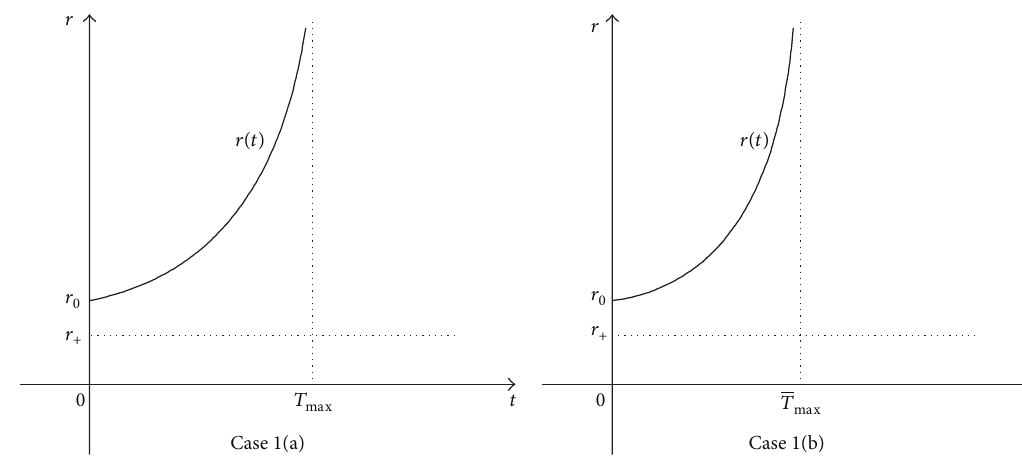
Figure 1: The graph of the solution 𝑟 = 𝑟(𝑡) for Cases 1(a) and